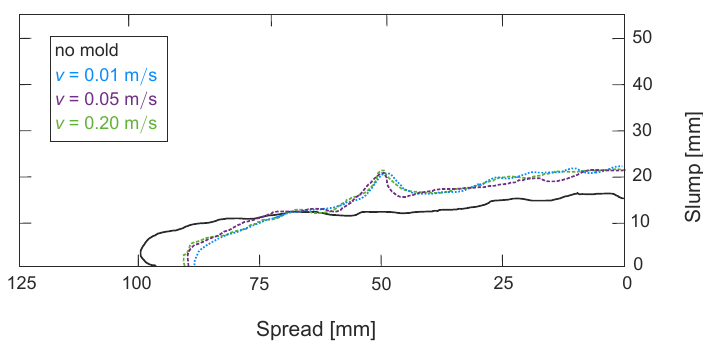
Figure 4. Results of spread and slump calculated with di ff erent mold lifting